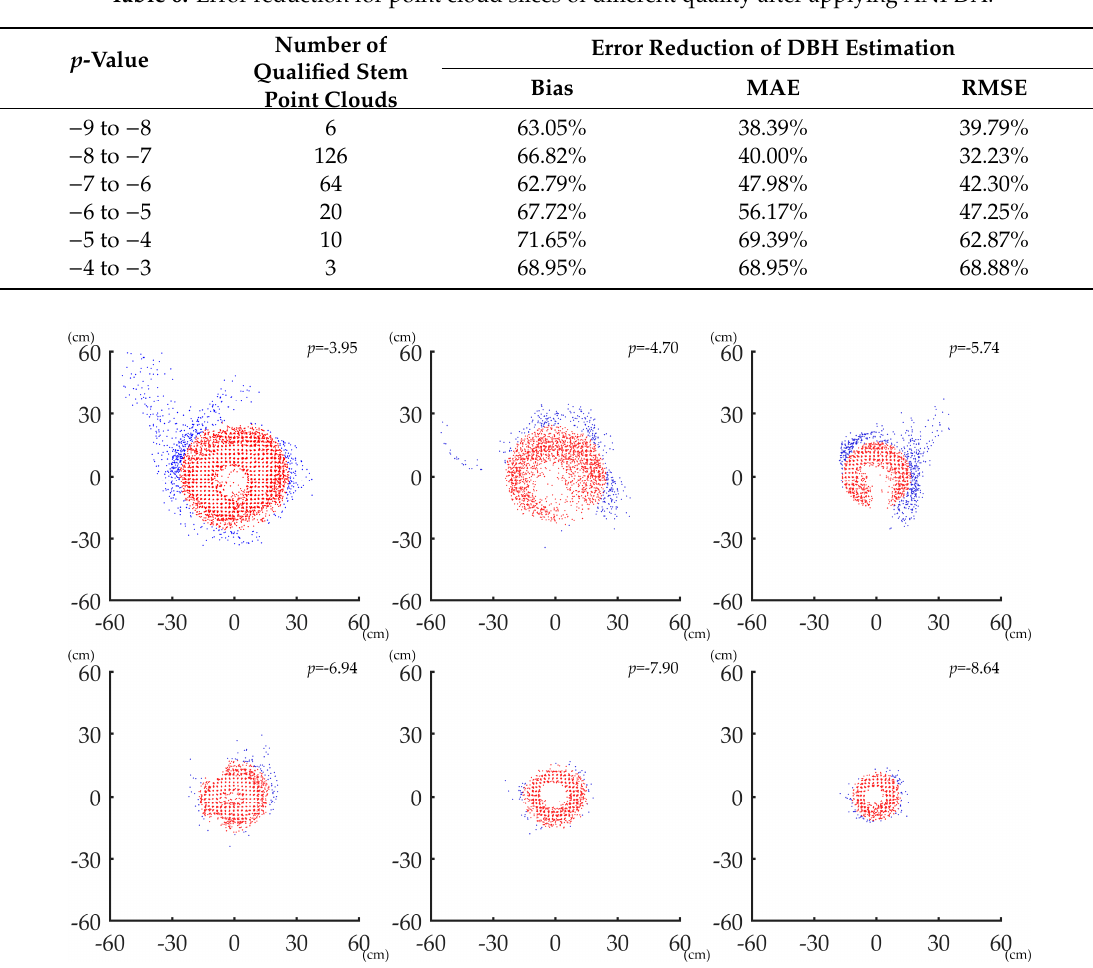
Figure 12. Examples of applying ANPDA on point clouds of di ff erent